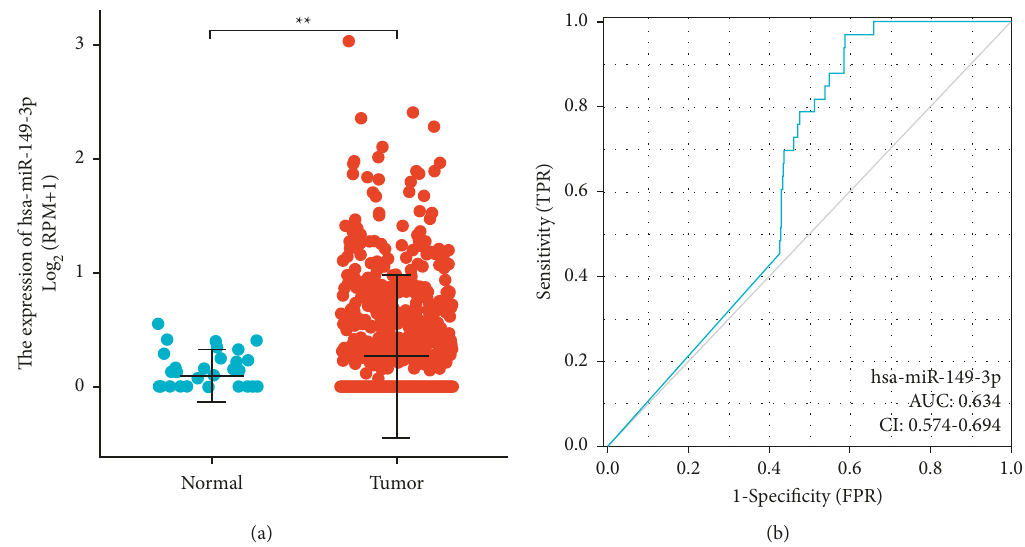
Figure 1: Expression of miR-149-3p in 537 UCEC and 33 normal tissues. (a) miR-149-3p relative expression levels (expressed in transcripts per million, TPM) were significantly higher in UCEC tissues (3.469 ± 0.0805) compared with normal tissues (2.70 ± 0.151). (b) ROC. Significance markers: ∗ ∗ P < 0 .